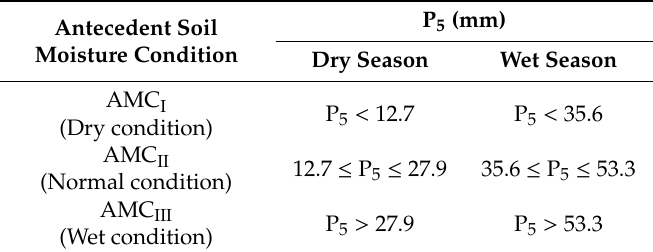
Table 2. Classification of antecedent soil moisture